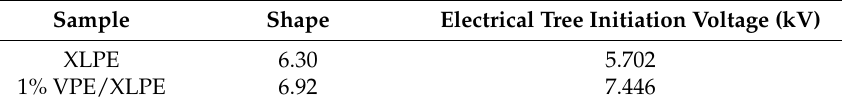
Table 2. Weibull distribution parameters of electrical tree initiation voltage.